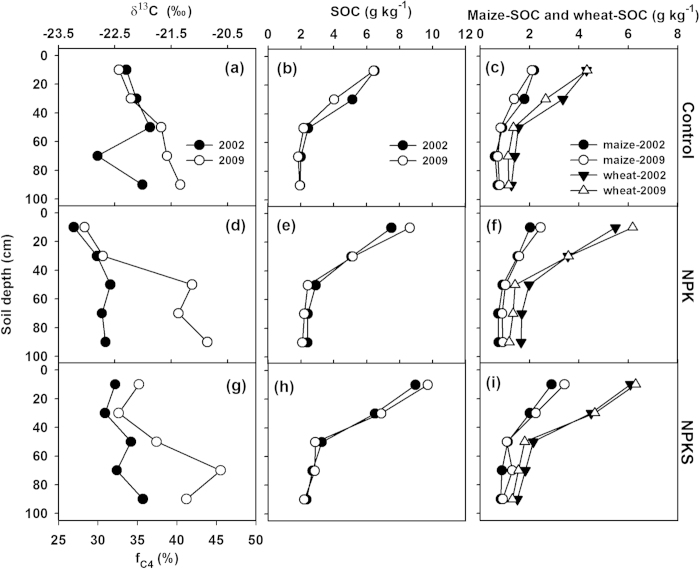
Vertical distributions of δ13C in SOC, fraction of maize derived SOC (fC4) (left column), total SOC (middle column), maize and wheat derived SOC (right column) under control (top row), NPK (middle row) and NPKS (bottom row) at Zhengzhou.